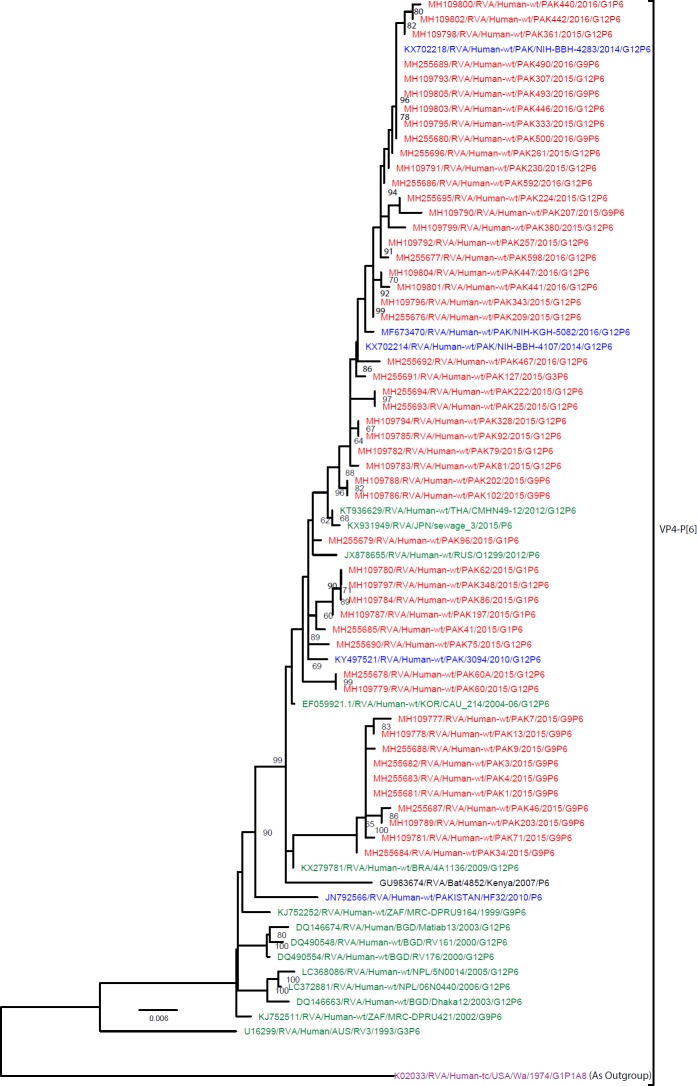
Maximum likelihood phylogenetic tree constructed from the nucleotide sequences of P[6]-VP4 strains and representative RVA strains with kimura-2-parameter model in MEGA program 6.0.Bootstrap values <60 are not shown. RVA strains sequenced in this study are represented by the red colour. Pakistani Strains reported in the previous studies are shown in blue. The out group strain is represented by purple colour, Bat RVA strain is represented by Black Colour while green shading represent strains isolated in all over the world. The RVA strains sequenced in this study and reference strains obtained from GenBank database are represented by Accession number, Strain Name, Country and year of Isolation. Scale bar: 0.006 substitutions per nucleotide.